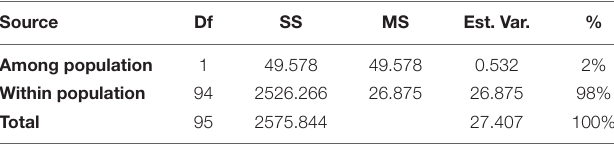
TABLE 2 | Analysis of molecular variance for sub-groups estimated by structure analysis.